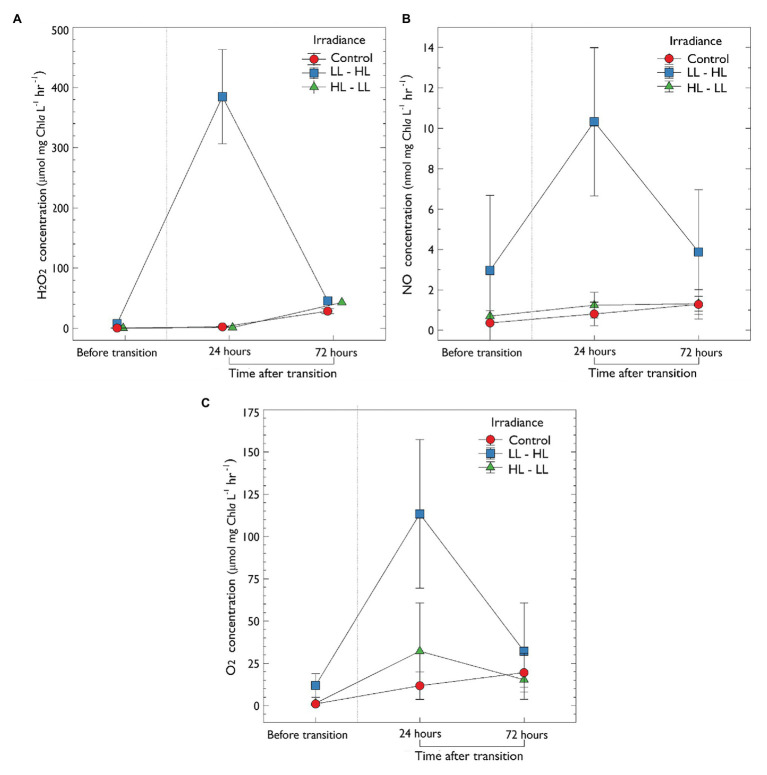

In-vitro production of extracellular metabolites determined by microsensors of ice-water interface algal exposed to one of three irradiance levels (1) LL – low light [0.5 thick snow (30 cm)], (2) mid-range – control, and (3) HL – high light. (A) Concentration of extracellular H2O2 (μmol mg chla L−1). (B) Nitric oxide concentration (nmol mg chla L−1). (C) Oxygen concentration (μmol mg chla L−1). Sea-ice algal communities were acclimated to their respective snow treatment for 10 days before sampling. After 10 days, an initial sample was collected, denoted “before transition”; following the acclimation period, irradiance either increased or decreased (via manipulation of snow-depth) as previously described. Samples were then collected at 24 and 72 h after the transition. Control, no change in irradiance; LL – HL, low light to high light; HL – LL, high light to low light. Error is the standard deviation of the mean (n = 3).